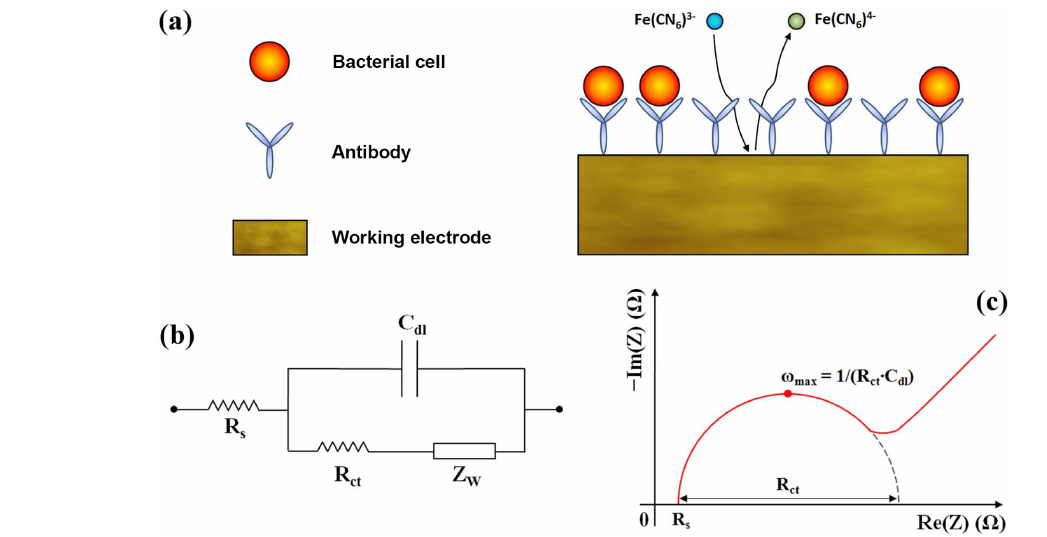
Figure 3. (a) Modified working electrode with immobilized bioreceptor; (b) equivalent electrical circuit of the biosensor; (c) Nyquist plot of the equivalent